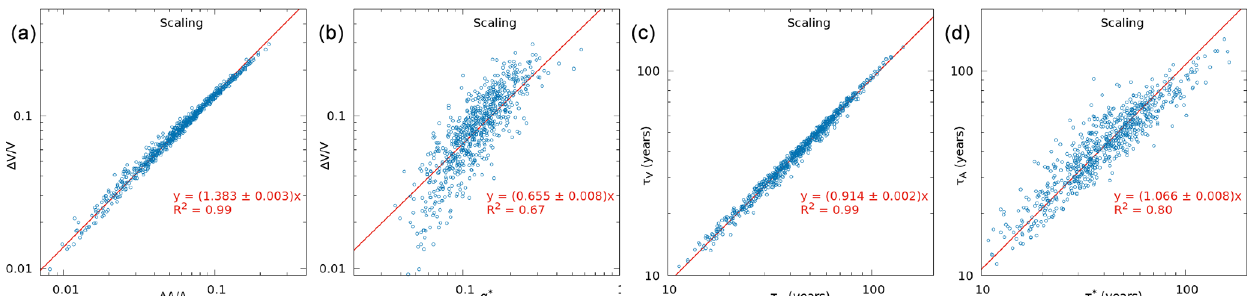
Figure 2. Scaling model simulations of the 703 synthetic Himalayan glacier show that (a) the best-fit (fractional) climate sensitivities of area and volume are proportional to each other, (b) the climate sensitivity of volume is proportional to α ∗ ≡ βδEτ times associated with glacier area and volume are approximately equal, and (d) the volume response time is approximately equal to τ ∗ ≡ (cid:16) b (cid:17) − 1 − + β t . In all the above plots, the corresponding best-fit curves are shown with red lines. The fit parameters and R 2 of the fits are γh also given. These numerical trends are consistent with theoretical results derived in Sect. 3.1.